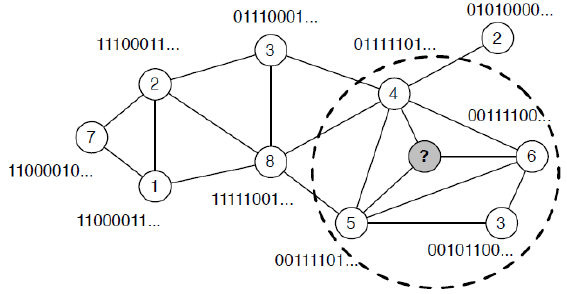
Figure 2. unoccupied slot-selection algorithm [30]